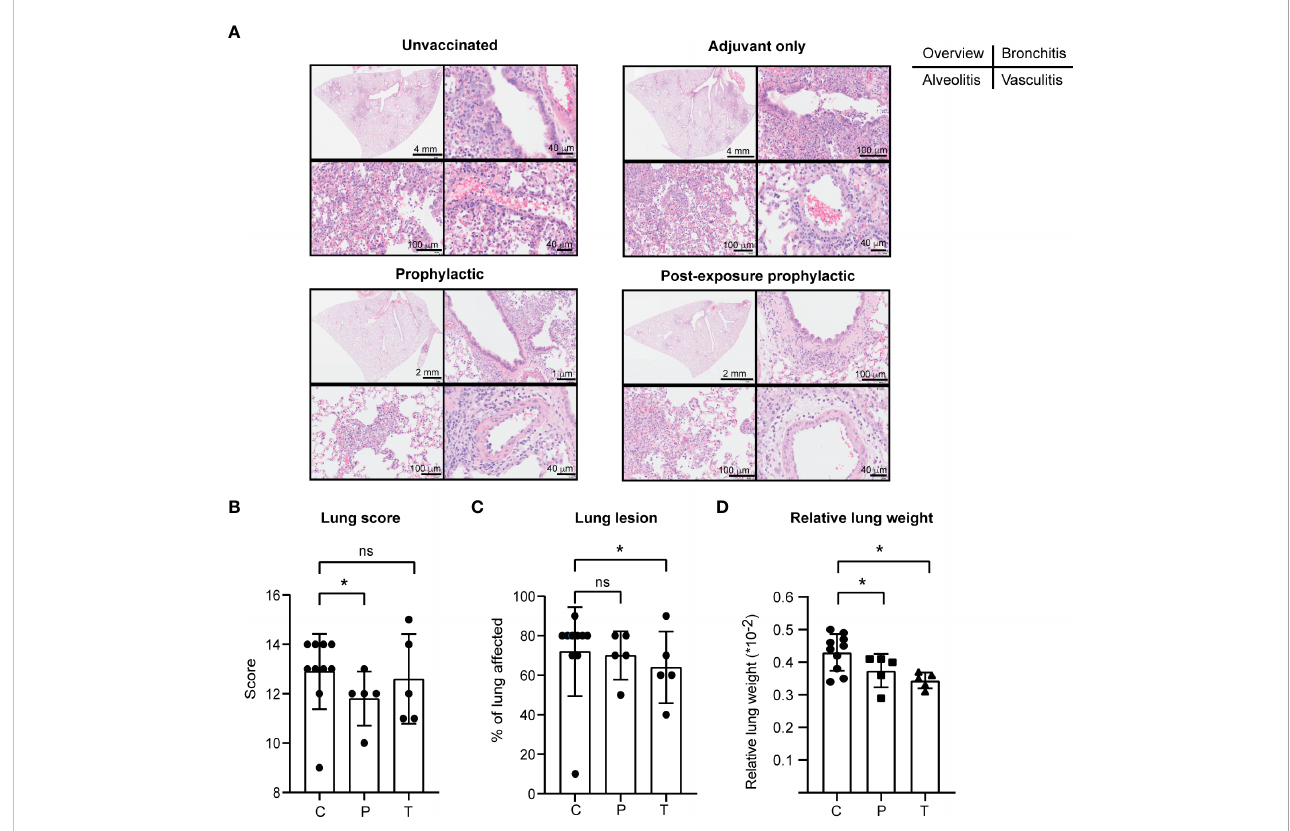
FIGURE 6 PolyPEPI-SCoV-2 decreases lung pathology of SARS-CoV-2 infected hamsters. (A) Lung scores (see subpanel B) were evaluated based on hematoxylin-eosin (H&E) stained tissue sections, examined by light microscopy. Representative results of one animal from each group on D49 are shown as follows: overview of the H&E stained lung (upper left panels), bronchitis (upper right panels), alveolitis (lower left panels), vasculitis (lower right panels). (B – D) Lung pathology was evaluated as lung score (B) , lung lesions (C) and relative lung weight (D) on D49. Data are presented as sum of the score of the disease parameters (detailed in Materials and Methods and in Supplementary Figure 5). (C) Gross pathology was evaluated on the whole lung lobes via visual observation by an independent pathologist and results provided as the % of lung area affected (lung lesion). (D) Relative lung weight illustrated as percentages of body weight [(lung weight/body weight)*100]. Results are shown as average ± SD of 5 animals (10 Controls) per group. C, challenge and adjuvant controls, P, prophylactic, T, post-exposure prophylactic. ns, p>0.05, (*) p<0.05 calculated using one-tailed Mann-Whitney